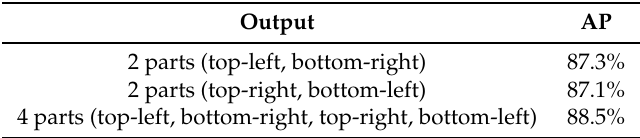
Table 1. The AP for different outputs of paired semantic segmentation network.